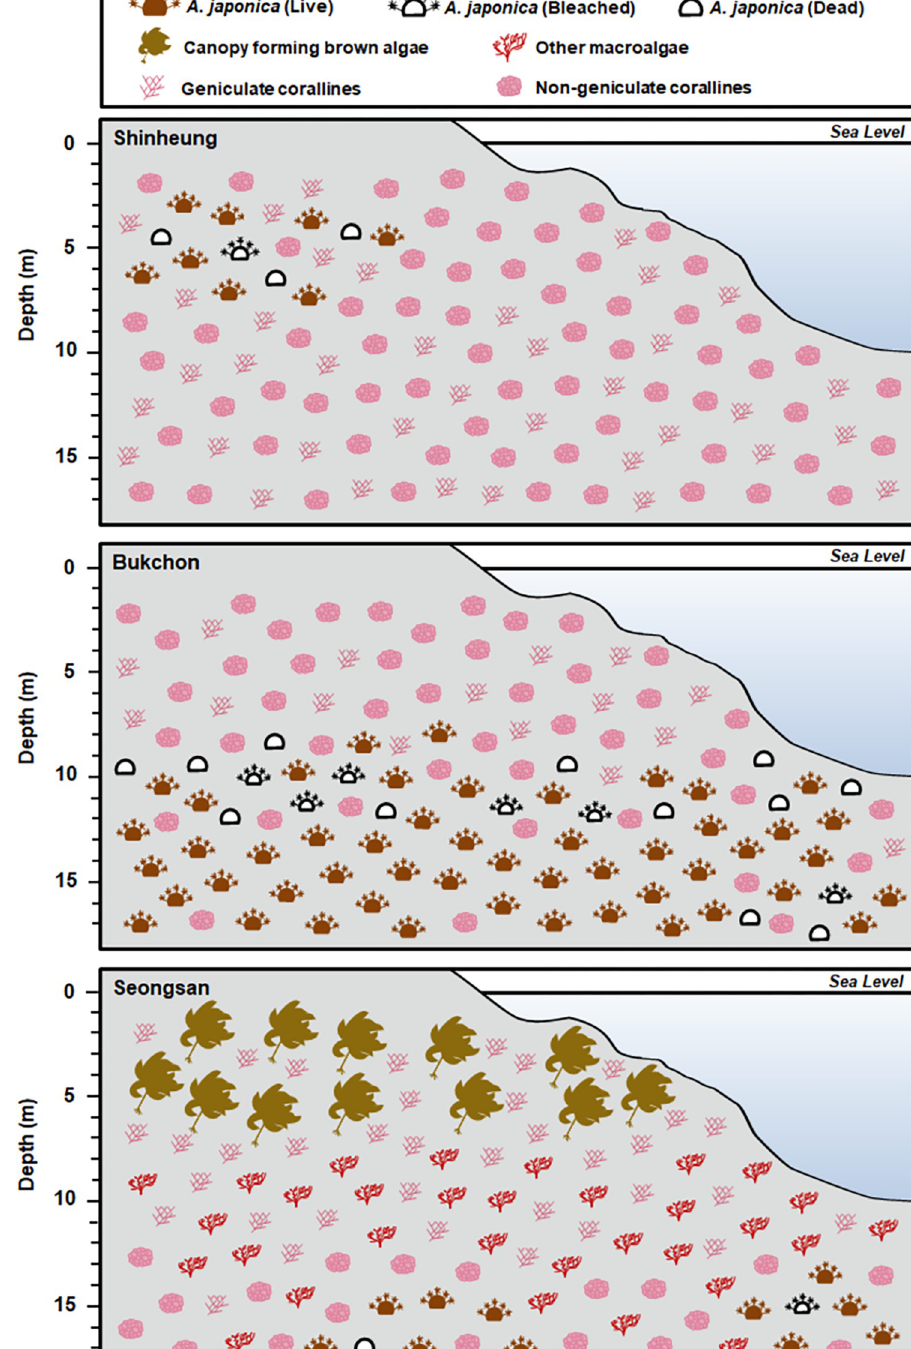
PLOS ONE | https://doi.org/10.1371/journal.pone.0275244 November4,